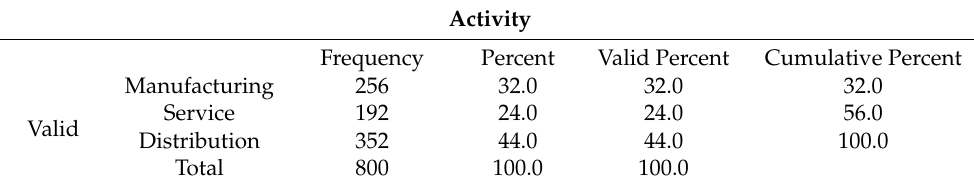
Table 2. Descriptive analysis for the activity of the investigated